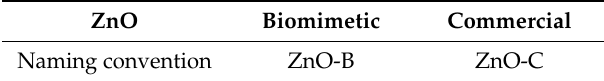
Table 1. Naming convention for powders under